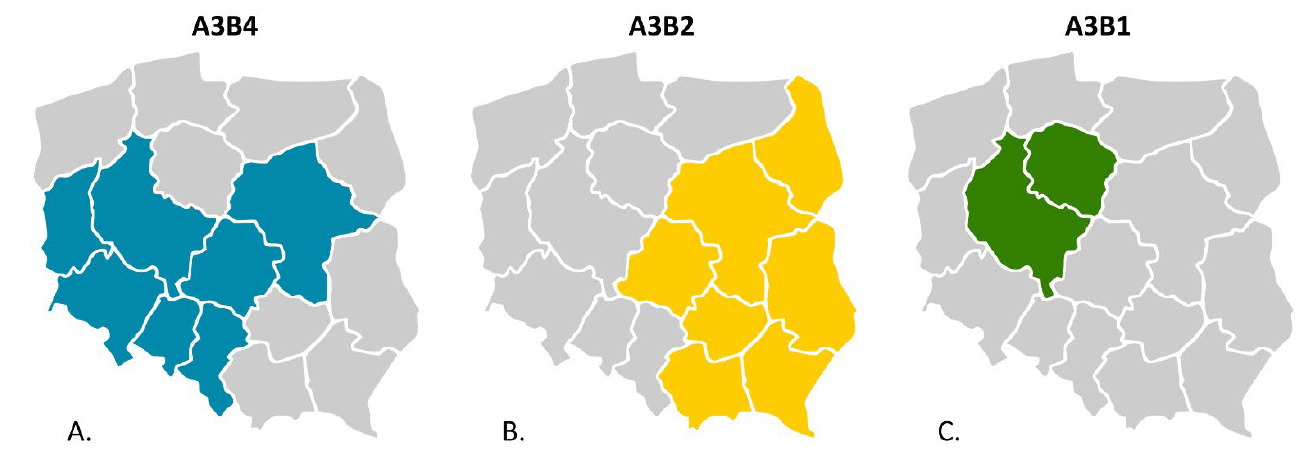
Figure 2. Depiction of administrative areas in Poland where IBDV field strains belonging to A3B4 ( A ), A3B2 ( B ), and A3B1 ( C ) genotypes were detected. The phylogenetic analysis based on partial VP2 nucleotide sequences showed that the Polish strains clustered in three separate branches within genogroup A3, which were designated as A3.1, A3.2, and A3.3 (Figure 3), while for VP1, they clustered in three dif- ferent genogroups: B1, B2, and B4 (Figure 1B). Cluster A3.1 grouped the reassortants of the A3B1 genotype, and cluster A3.2 gathered the very virulent A3B2 strains, while the collected strains in cluster A3.3 represented the A3B4 genotype, indicating separate evo- lution of the VP2 gene of these three Polish IBDV lineages despite belonging to the same genogroup A3. Table 2. List of field strains circulated in Poland 2016–2022.